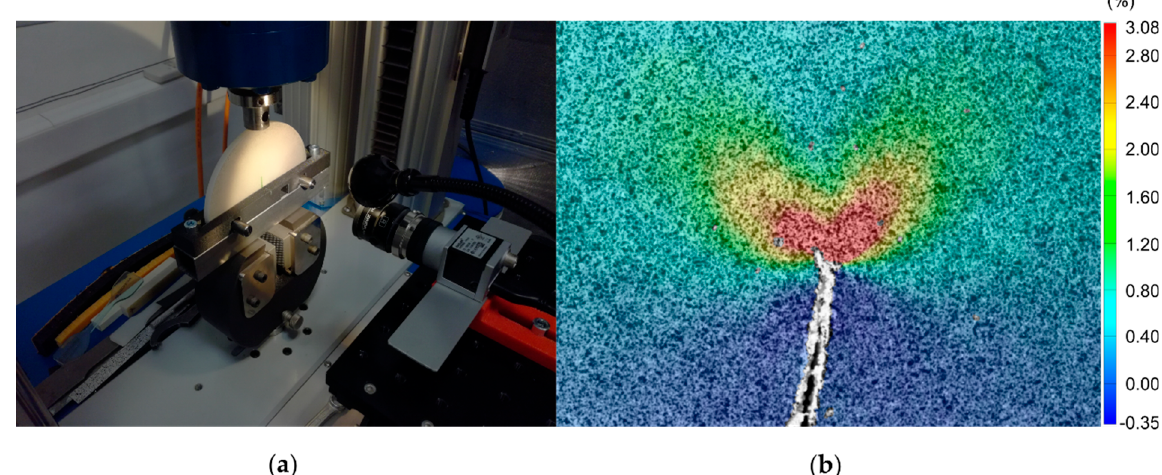
Figure 2. ( a ) Experimental setup; ( b ) y-strain field around the crack tip obtained by the digital image correlation (DIC) for a 10–42–42 test configuration.